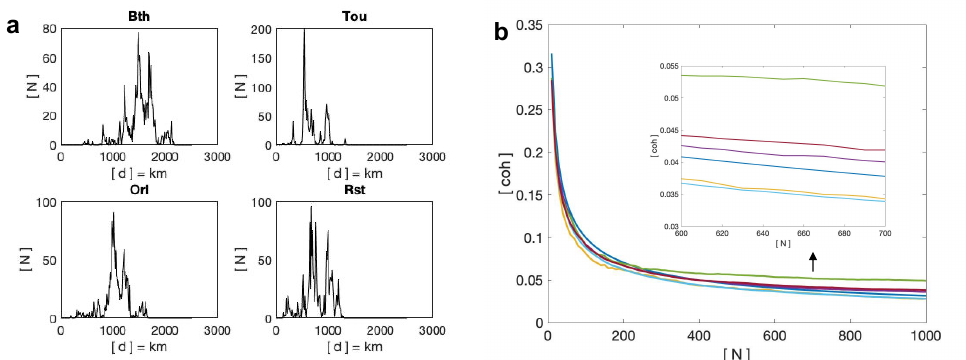
Figure 3. ( a ) Distance distribution for events recorded from different locations. ( b ) Noise coherency with different event numbers. This figure shows theoretical coherency noise values (blue), the coherency of noises recorded at Bath (yellow), Toulouse (purple), Orleans (green), and Rustrel (sky, blue), and event threshold coherency